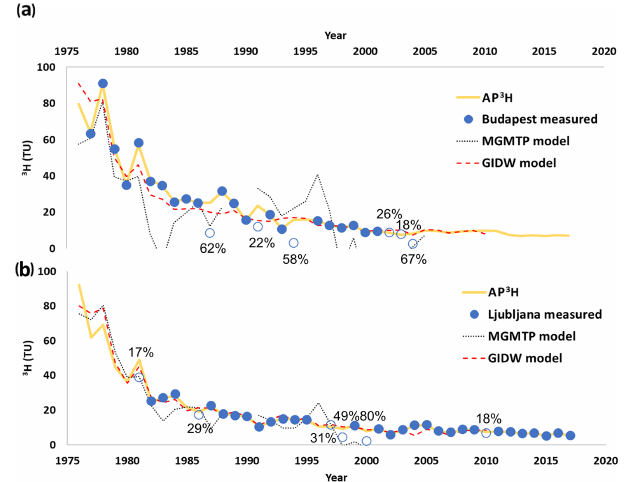
Figure 3. Measured and estimated 3 H values at (a) Budapest, Hungary, and (b) Ljubljana, Slovenia, between 1976 and 2017. The dotted black lines indicate the estimations of the “modified global model of tritium in precipitation” (MGMTP; Zhang et al., 2011), and the dashed red ones indicate the global inverse distance weighted model (GIDW; Jasechko and Taylor, 2015). Note here that uninterpretable negative estimates of the MGMTP were not shown. The empty circles indicate an incomplete year, in which the given 3 H value was not used for interpolation in the AP 3 H database, and the percentages next to these symbols indicate the ratio of fallen precipitation not analyzed for 3 H in a given year.